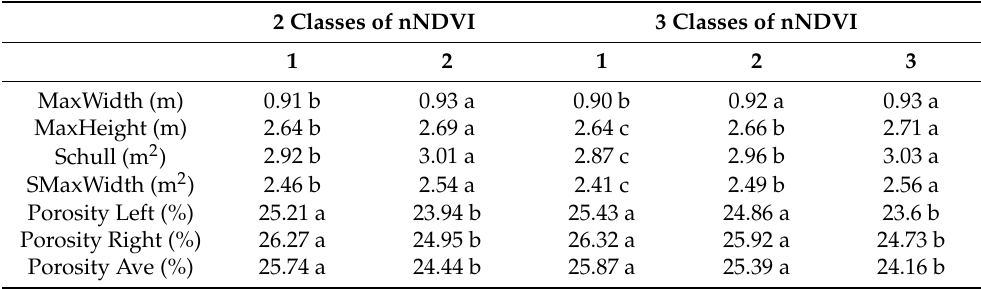
Table 7. Analysis of variance (ANOVA) of the structural and geometric orchard variables according to nNDVI classes as result of k-means clustering. Different letters (a, b; or a, b, c) indicate different groups with a p -value <